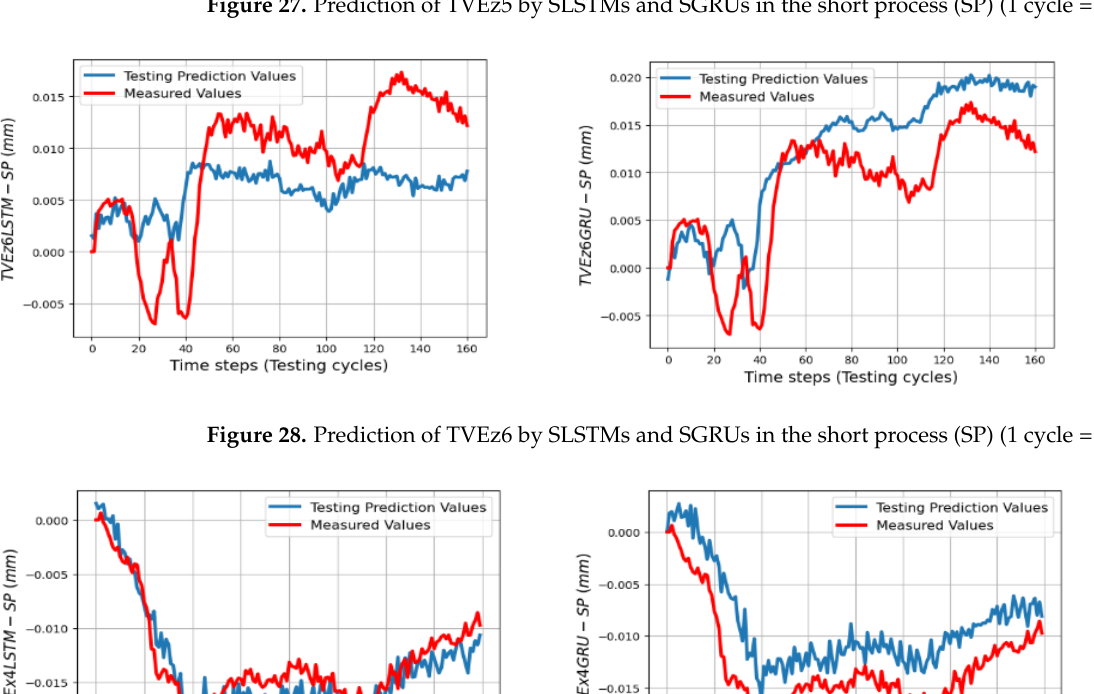
Figure 27. Prediction of TVEz5 by SLSTMs and SGRUs in the short process (SP) (1 cycle = 15 min).